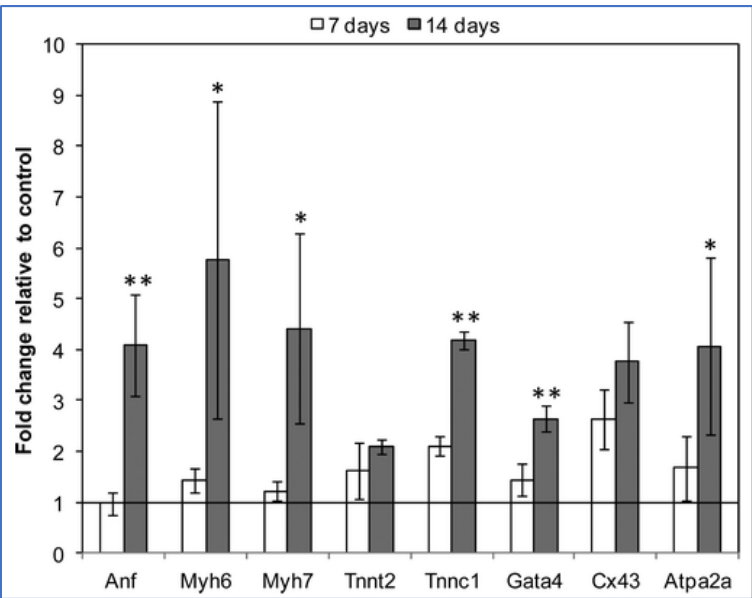
Figure 5. Gene expression data of cardiomyocytes cultured on chitosan/carbon scaffolds for 7 days and 14 days vs. control samples (chitosan scaffolds cultured using the same conditions) [33]. The fold change in gene expression is relative to the control (chitosan/carbon/cell constructs vs. chitosan/cell constructs). * p < 0.01; ** p < 0.05. (Anf = atrial natriuretic factor, Myh6/Myh7 = myosin heavy chain, Tnnc1 = troponin C type 1, Cx43 = gap junction α -1 or connexin 43, Atpa2a2 = calcium transporting ATPase).